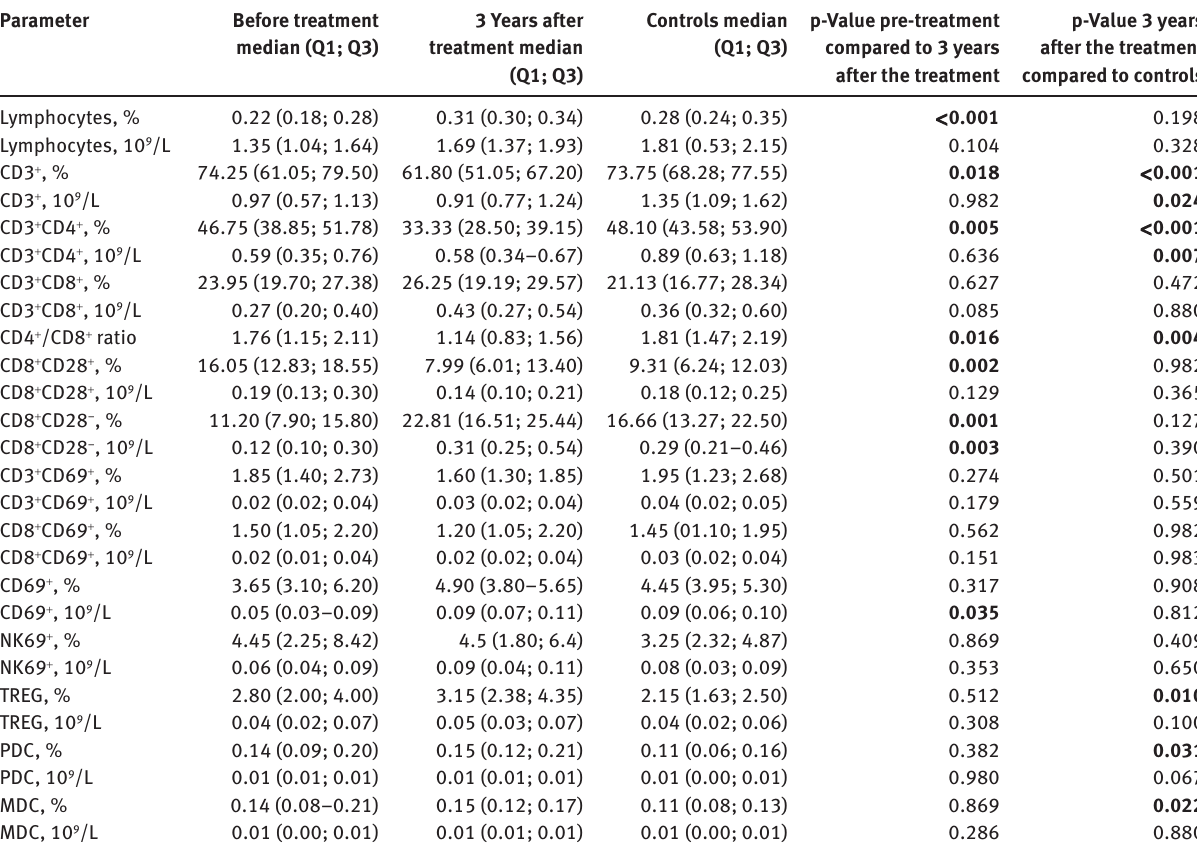
Table 5: Comparison of peripheral blood lymphocytes before and 3 years after treatment in cohort A.